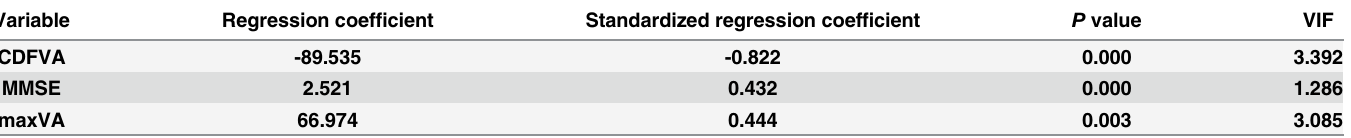
Table 5. Results of multivariate regression analysis with stepwise selection in terms of the CAR of the VFIT-EV.